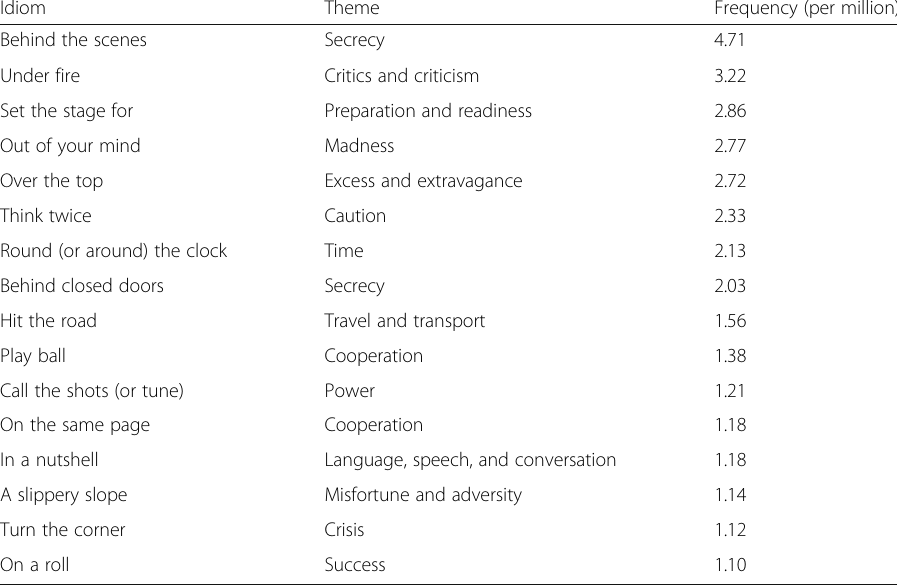
Table 3 The idioms with the frequency of more than 1 per million Idiom Theme Frequency (per million) Behind the